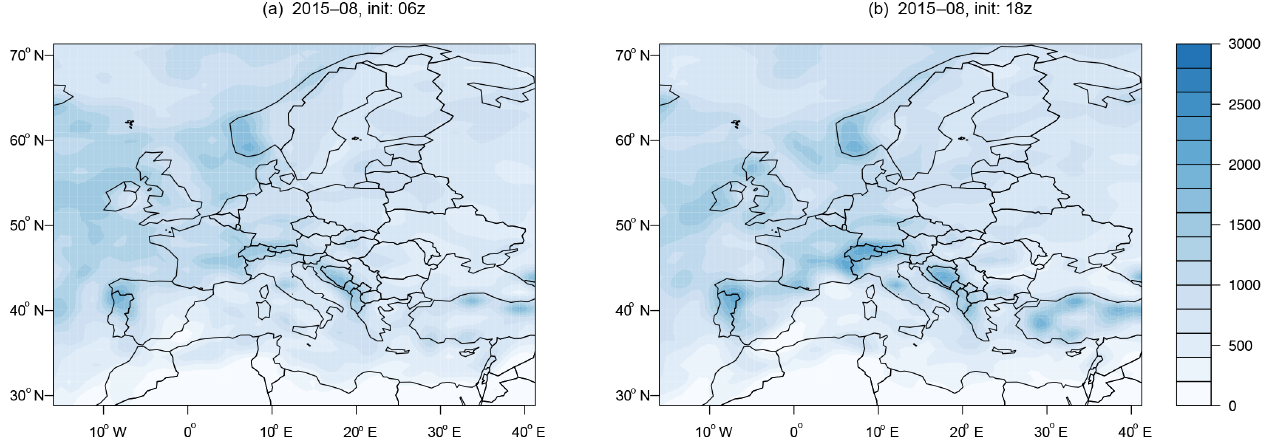
Figure 7. Areal distribution of precipitation depth in mm for the period August 2015–May 2016 as predicted on 10 August 2015 by two CFSv2 runs initialised at (a) 06:00z and (b) 18:00z,